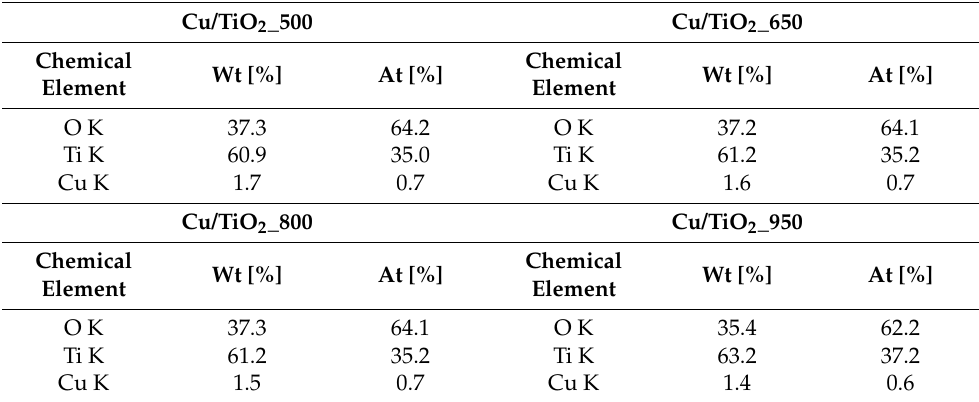
Figure 6. SEM images of the Cu/TiO 2 _950 sample, ( a ) Cu/TiO 2 _950 with 5000× magnification, ( b ) Cu/TiO 2 _950 with 8000× magnification.